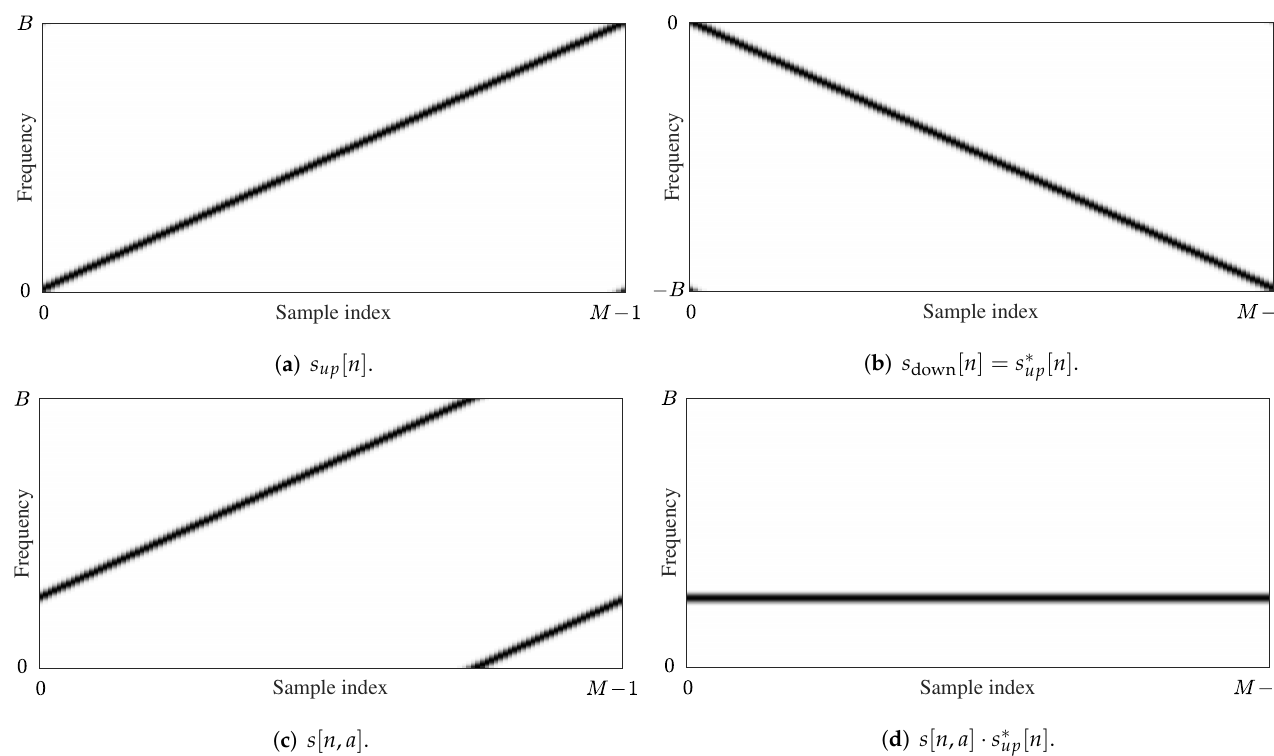
Figure 1. Spectrograms of the waveforms for an up-chirp s up [ n ] , a down-chirp s down [ n ] = s ∗ up [ n ] , an arbitrary LoRa symbol s [ n , a ] , and the product s [ n , a ] · s ∗ up [ n ] as applied in (4), for K = 1 and N = M